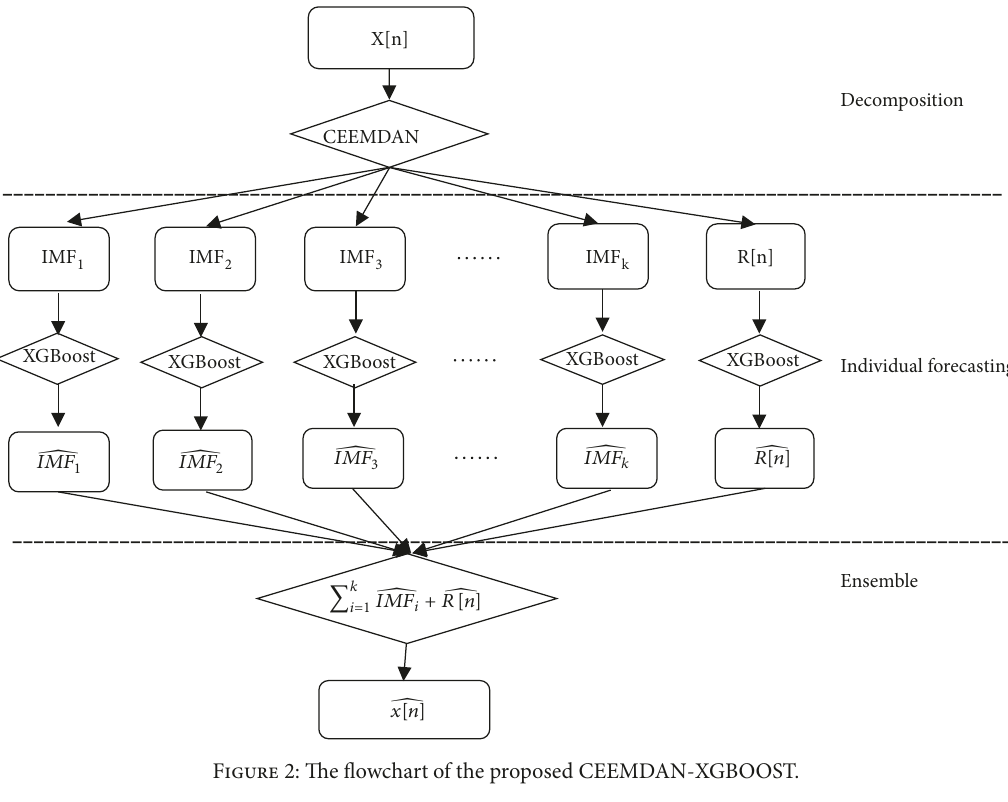
Figure 2: The flowchart of the proposed CEEMDAN-XGBOOST.